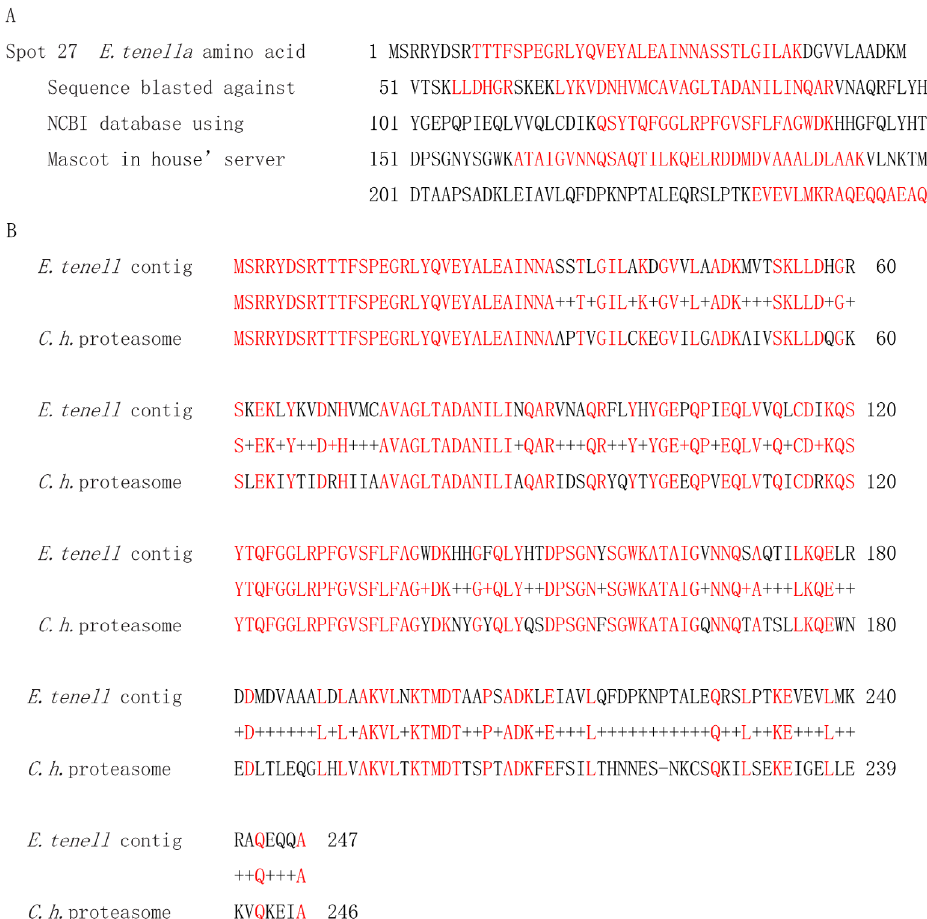
Figure 3. Spot 27 ’ s amino acid sequence homologous to Cryptosporidium hominis proteasome searched against the E. tenella genome using the ‘ Mascot in-house ’ server. A: E. tenella amino acid sequences obtained by MALDI-TOF-MS were searched using BLAST against the NCBI database. Deduced amino acid sequences on Spot 27 were aligned with the deduced sequence from the E. tenella genome Contig 12511: complements (12140 … 13529) are in bold red script. B: Alignment of the predicted amino acid sequence from Spot 27 (A) with the C. hominis proteasome subunit. The alignments of sequences are in bold red